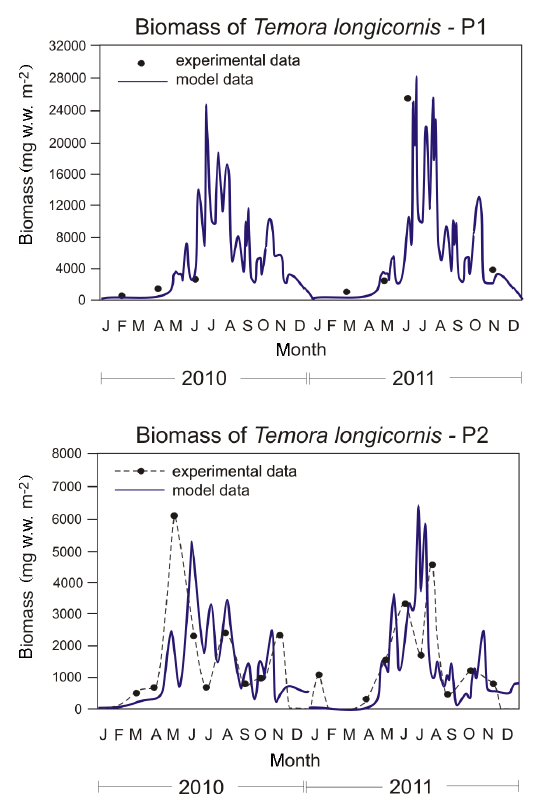
Fig. 7. The consolidated biomass of Temora longicornis in the water column at stations P1 – Gda ń sk Deep and P2 – Gulf of Gda ń sk based on in situ model data in 2010 and